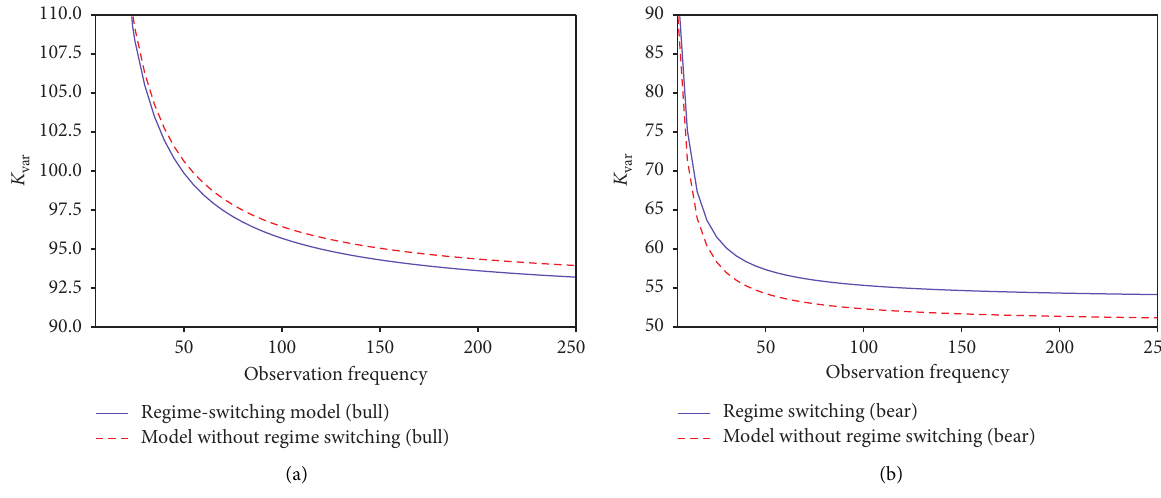
Figure 3: Comparison of K with and without regime switching: Merton-type jump. (a) State 1. (b) State var